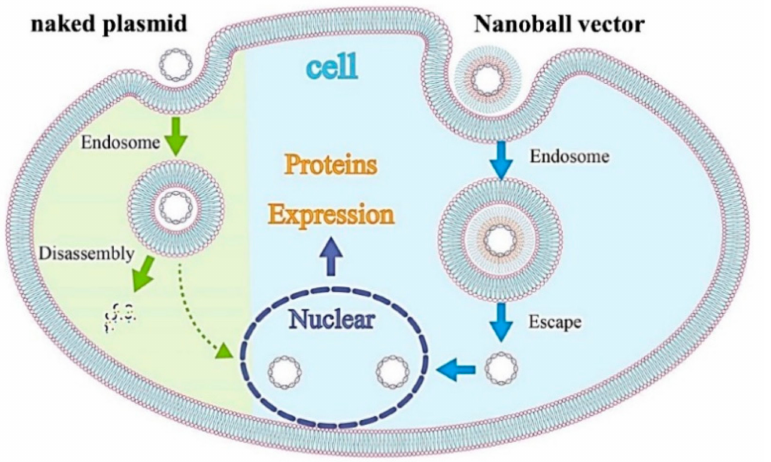
Figure 9. Schematic diagram of the transfection mechanism by a nanoball. Anionic materials have difficulty passing through the cell membrane by simple diffusion because of electrostatic repulsion by the membrane. Therefore, they are considered to be taken up into cells via caveolae-mediated endocytosis after binding with a specific receptor on the cell surface. After being taken up, they are generally disassembled in late endosomes or lysosomes. For nanoballs, endosome escape is easy because of the proton sponge effect by the high three-dimensional spatial ability of DGL. After escaping from the endosome and being released into the cytoplasm, the protein is expressed by the translocation of the plasmid to the nucleus. However, the mechanistic details of intracellular transport from endosomes to the nucleus remain